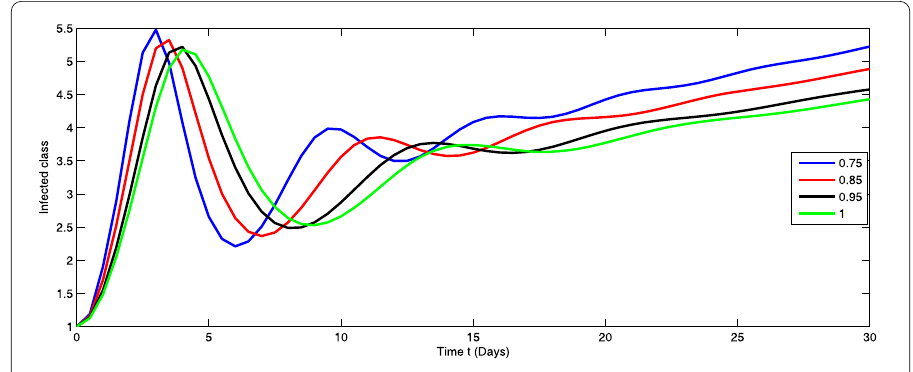
Figure 2 Graphical representation of the approximate solution I for the first ten terms at different fractional order